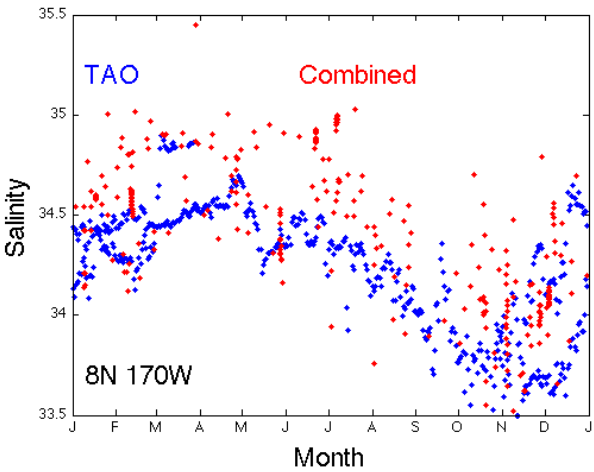
Fig. 6. Example of the seasonal cycle in the 2 . 5 ◦ × 2 . 5 ◦ box cen- tered at 8 ◦ N, 170 ◦ W. In blue are TAO mooring data from that lo- cation and in red are the combined SLS data from that box. Data are displayed by month to emphasize the seasonal